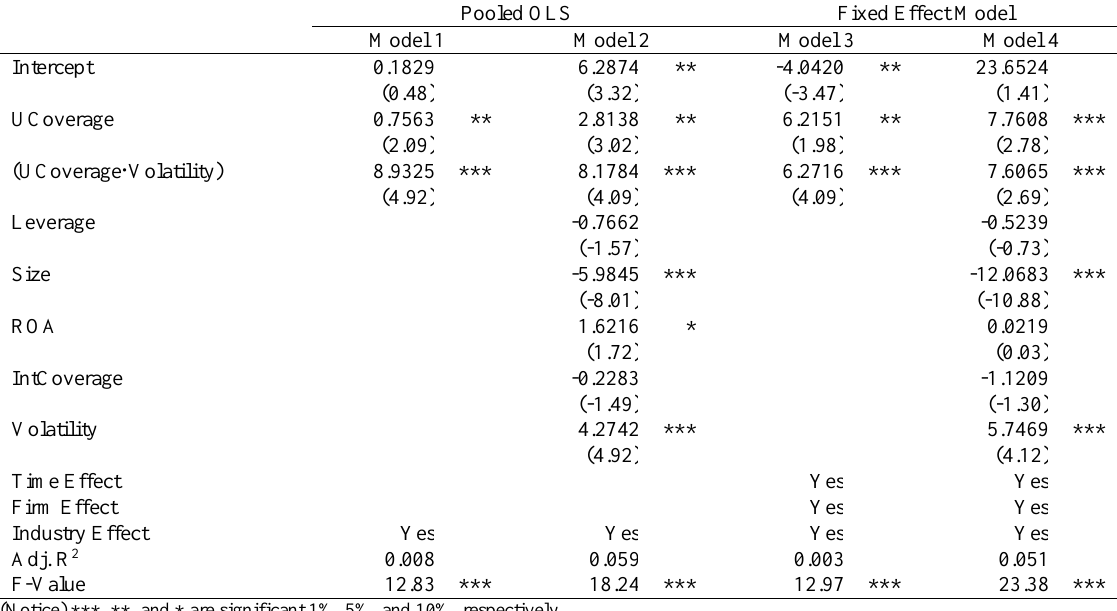
Table 8: Test results on hypothesis 2 for equity cost by using union coverage